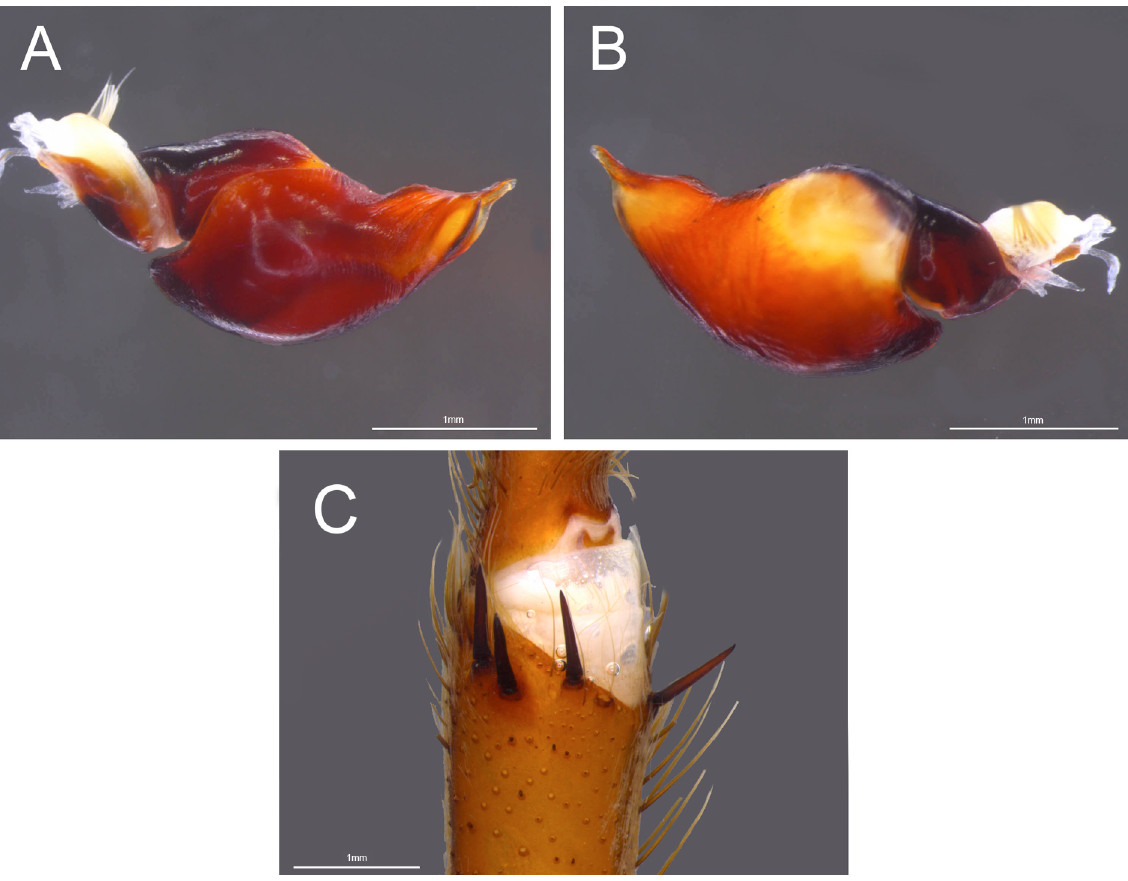
Fig. 19. Umbyquyra araguaia gen. et sp. nov., paratype, ♂, Serra do Lajeado, Tocantins, Brazil (IBSP 110473). A . Palp, prolateral. B . Retrolateral. C . Tibial apophysis,